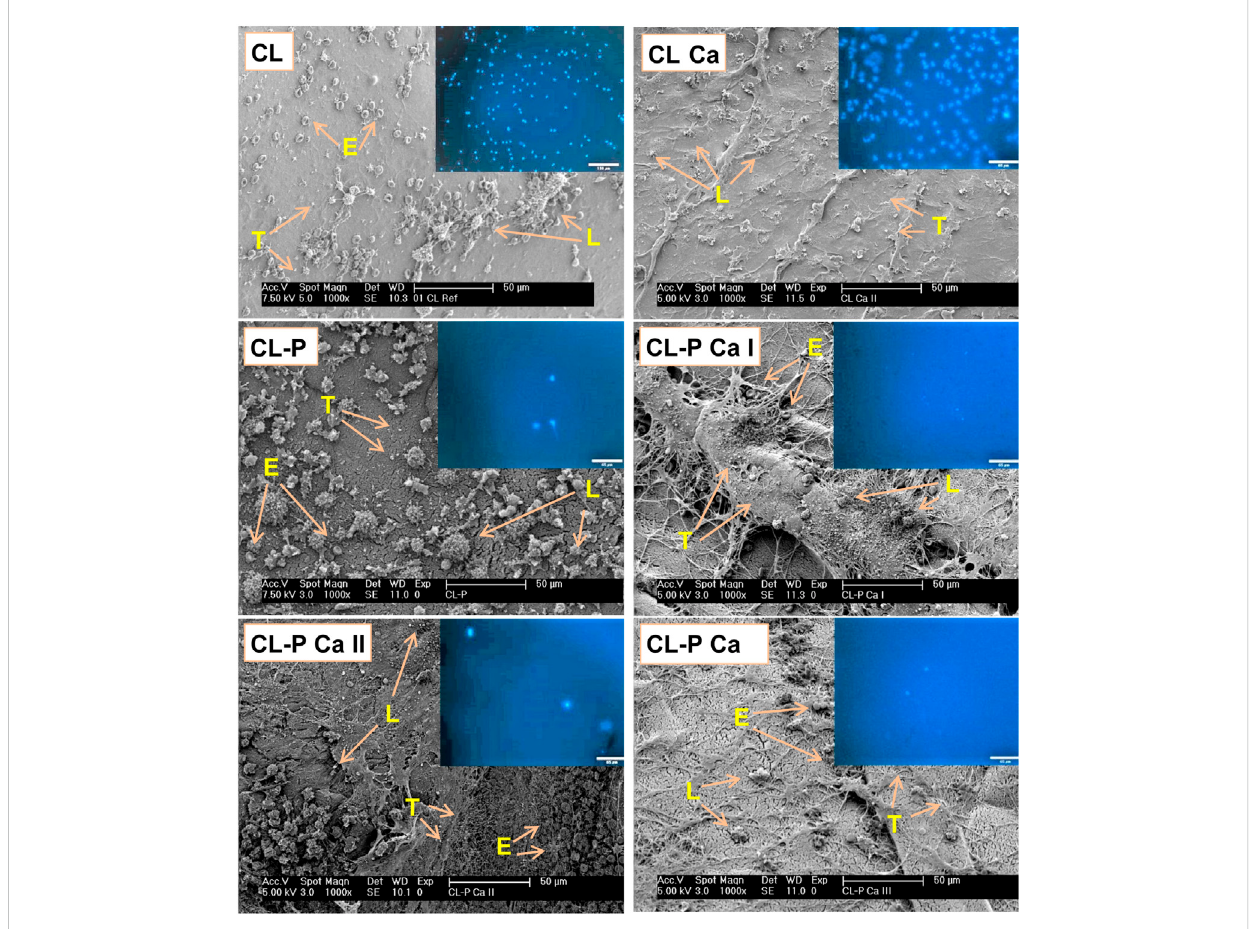
FIGURE 7 SEM and fl uorescence images (inserts) of the (aero)gel membranes of the cotton linters sample series after incubation with whole human blood (E: erythrocytes, L: lymphocytes, T: thrombocytes). Bright blue dots in the fl uorescence images represent the nuclei of adherent leukocytes (DAPI staining).